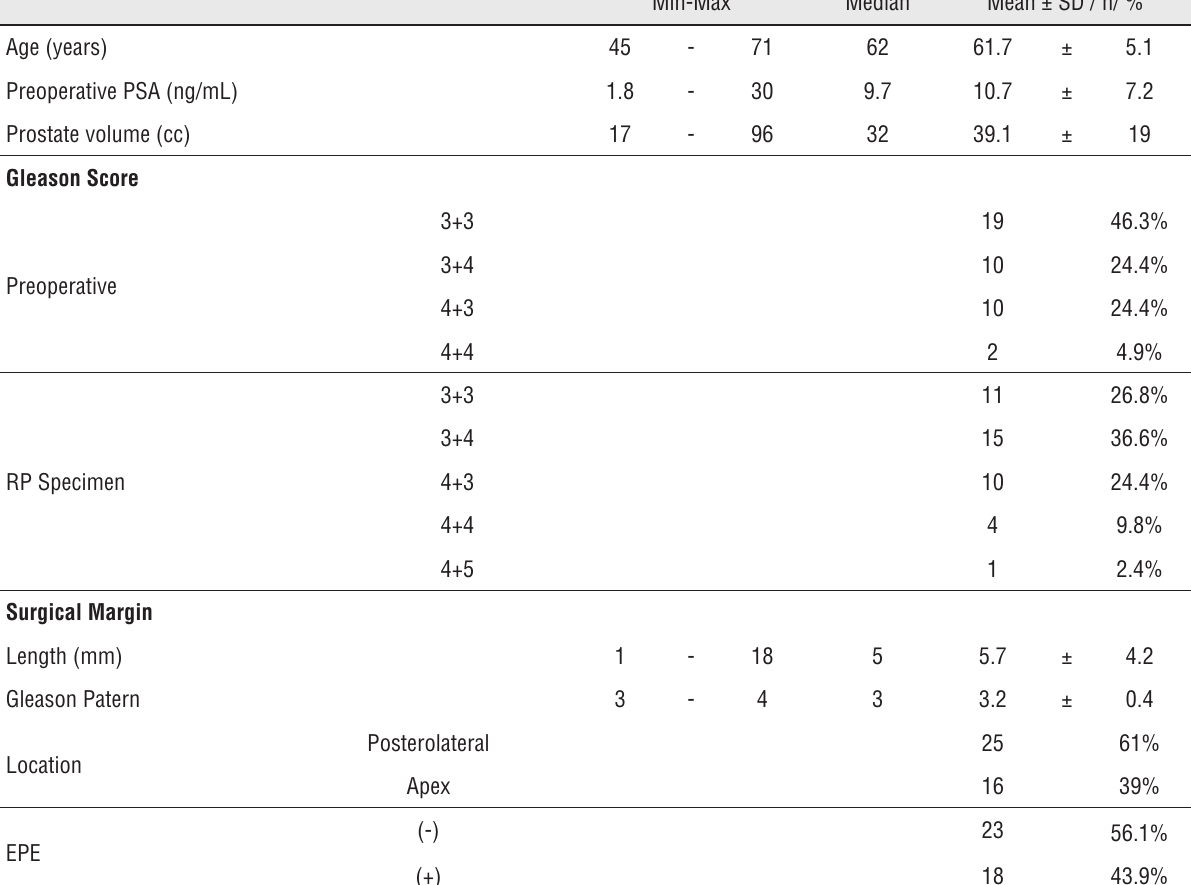
Table 1 - Preoperative and postoperative